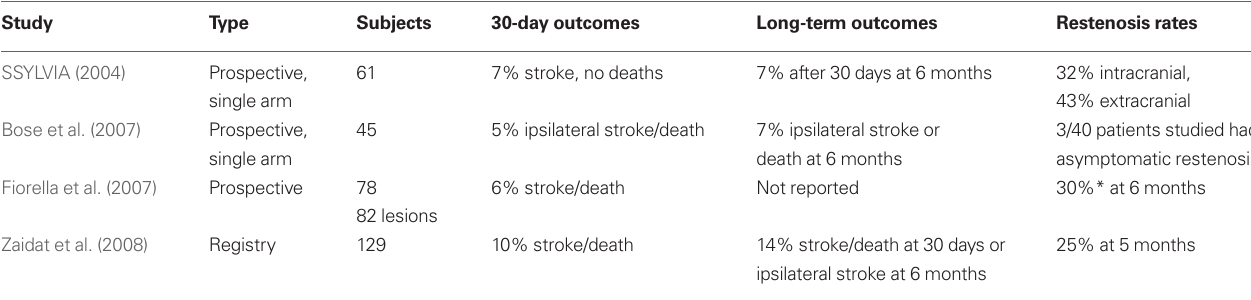
*Reported by Levy et al.,